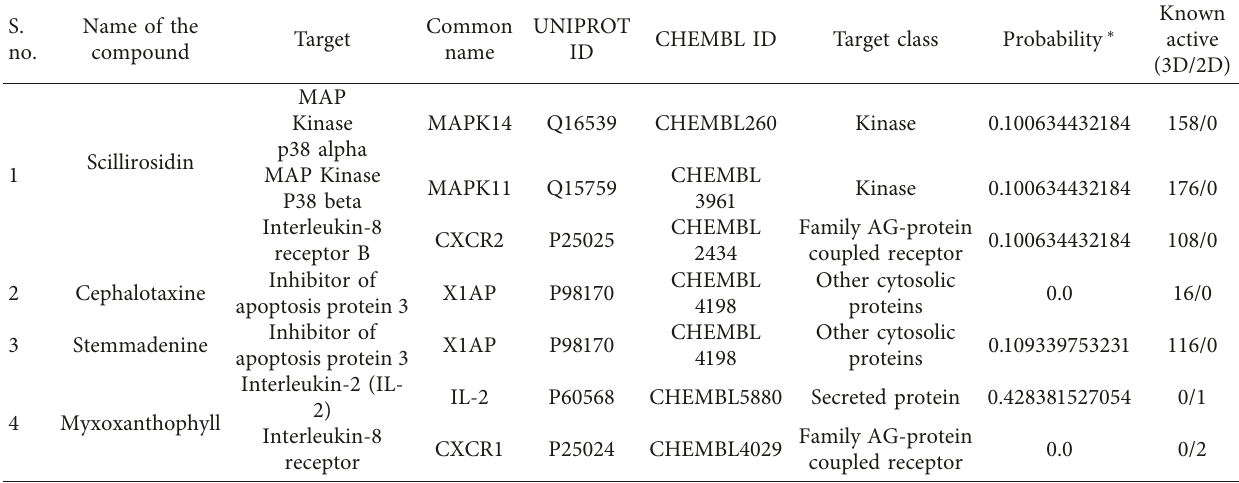
Table 8: Swiss Target Prediction for the bioactive isolate.